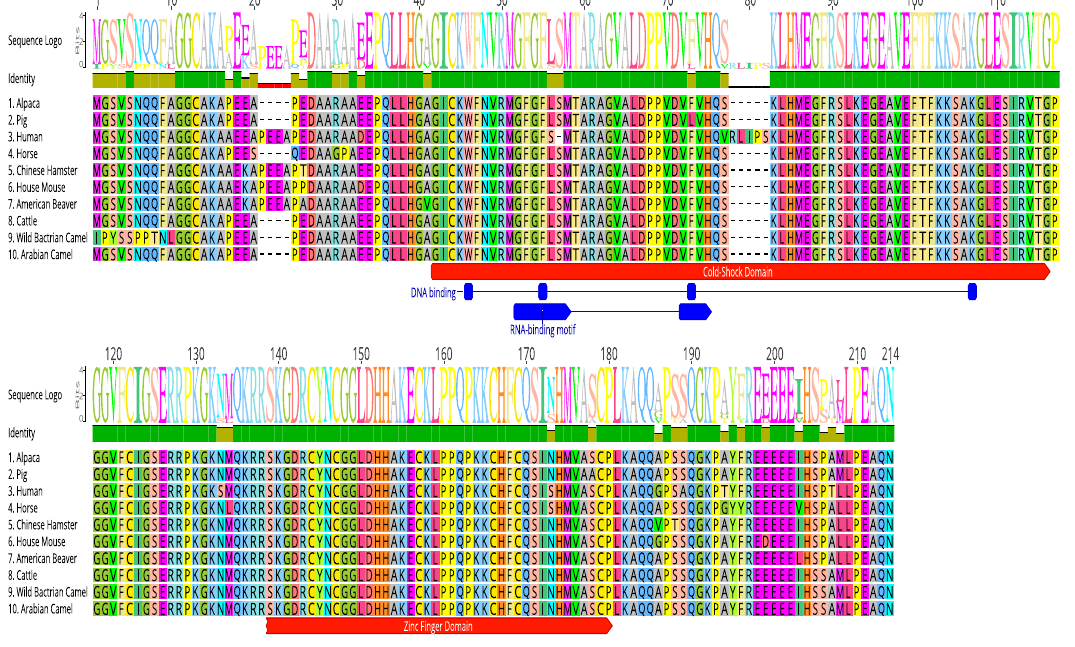
Figure 8. Multiple alignment of the amino acid sequence of cLin-28 protein with nine other mammalian species. Identical amino acids are marked in green, and typical cold shock and zinc finger domains are shown in red. RNA/DNA-binding domains are revealed in